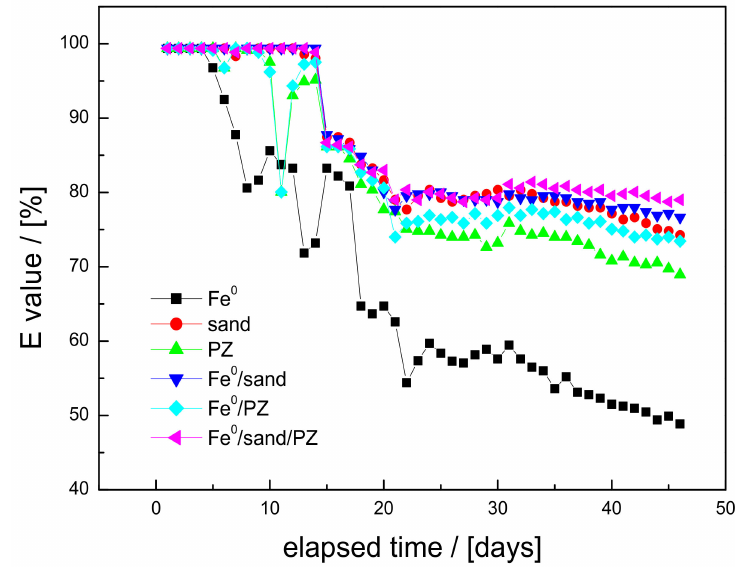
Figure 4. Time-dependent changes of methylene blue (MB) discoloration by the investigated systems. Experimental conditions: 6 g Fe 0 ; [MB] = 2.0 mg · L − 1 . Filling materials: metallic iron (Fe 0 ), sand and pozzolan (PZ). Column length 11.5 cm; column diameter 3.0 cm. The lines are not fitting functions, they simply connect points to facilitate